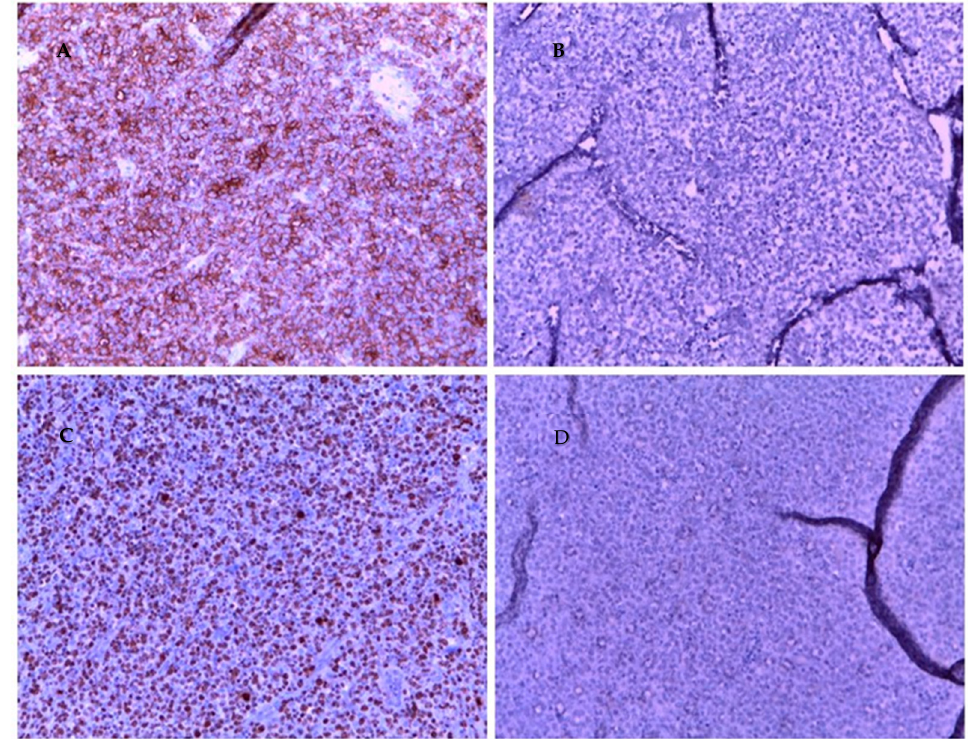
Figure 2. Immunohistochemistry of cervical mass biopsy, 20× magnification. ( A ): CD 20 positive. ( B ): CKAE1 AE3 negative. ( C ): high Ki 67. ( D ): SOX 10 neg.